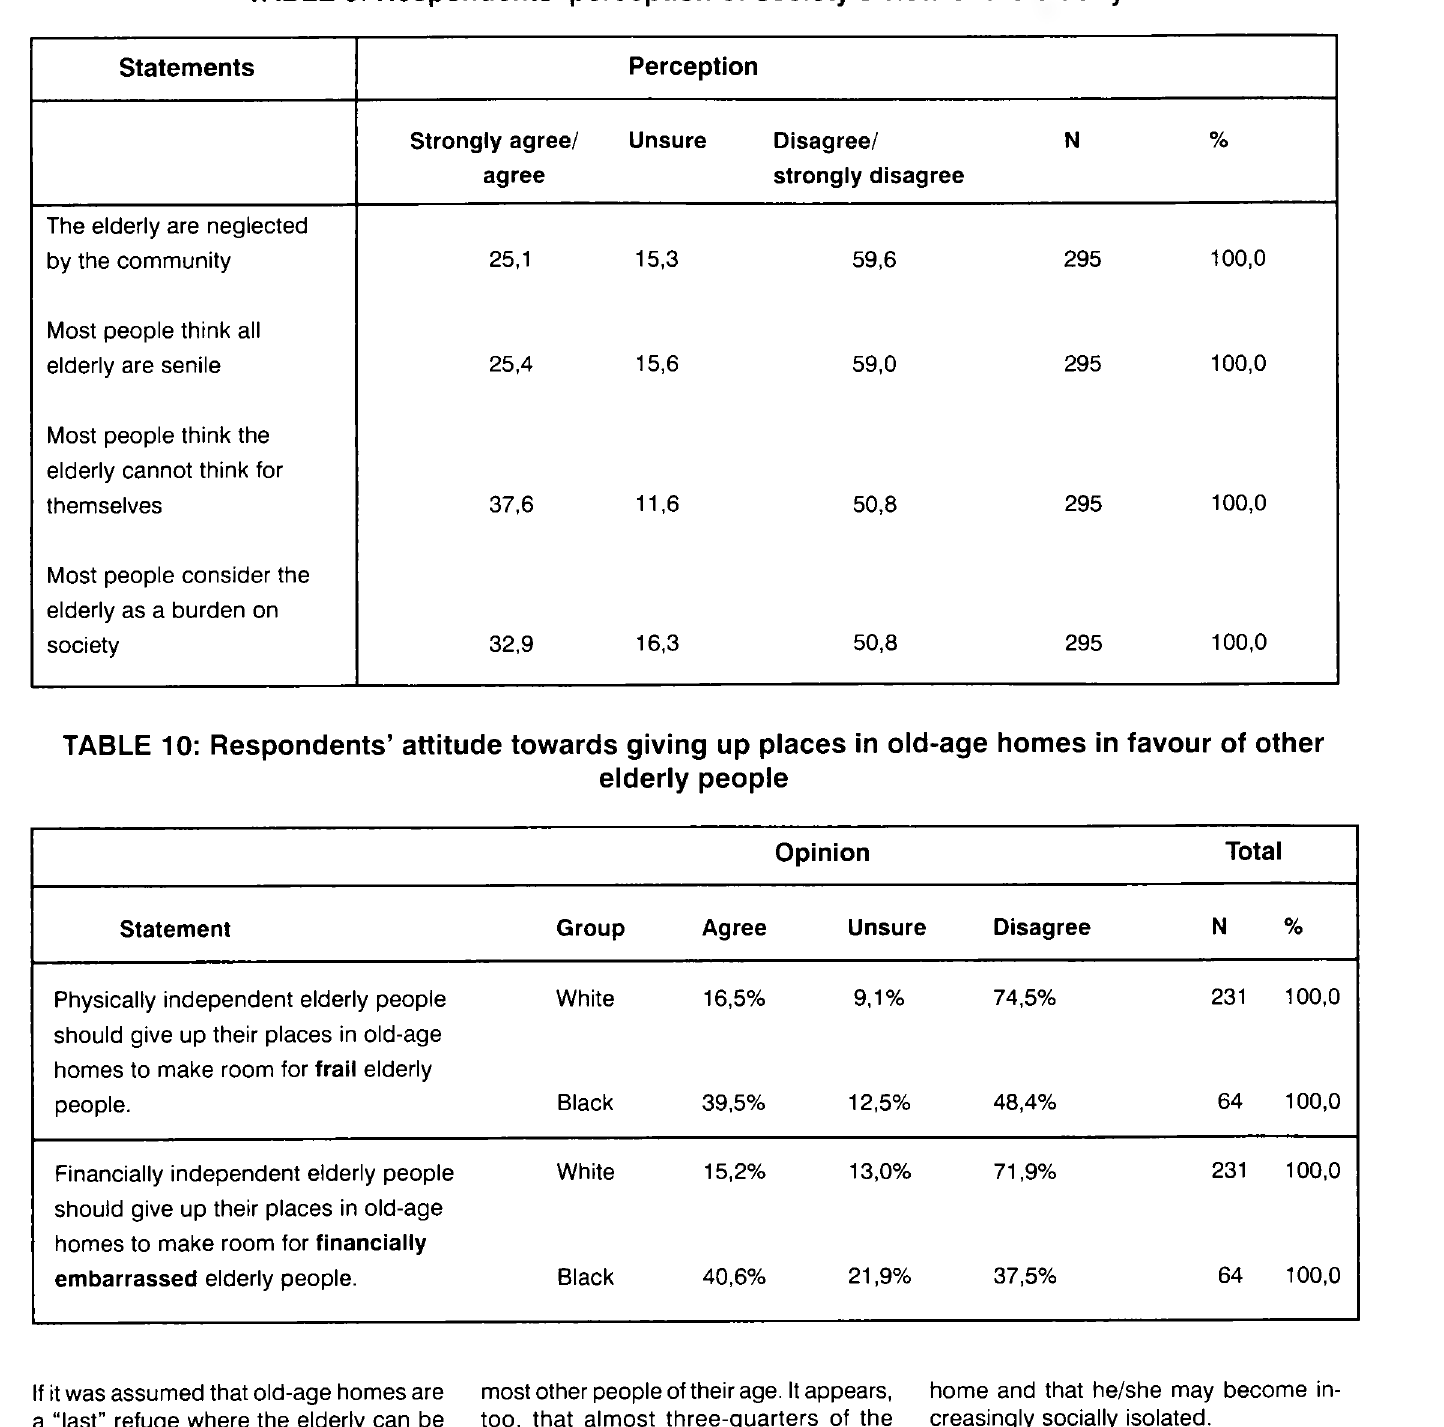
TABLE 9: Respondents’ perception of society’s view of the elderly